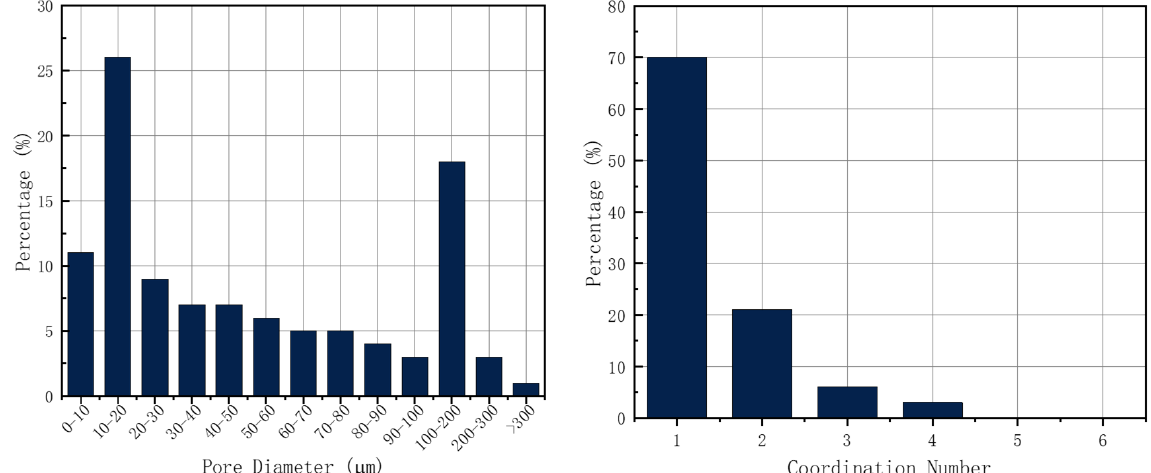
Figure 13. PNM of CZ-Y47-1.